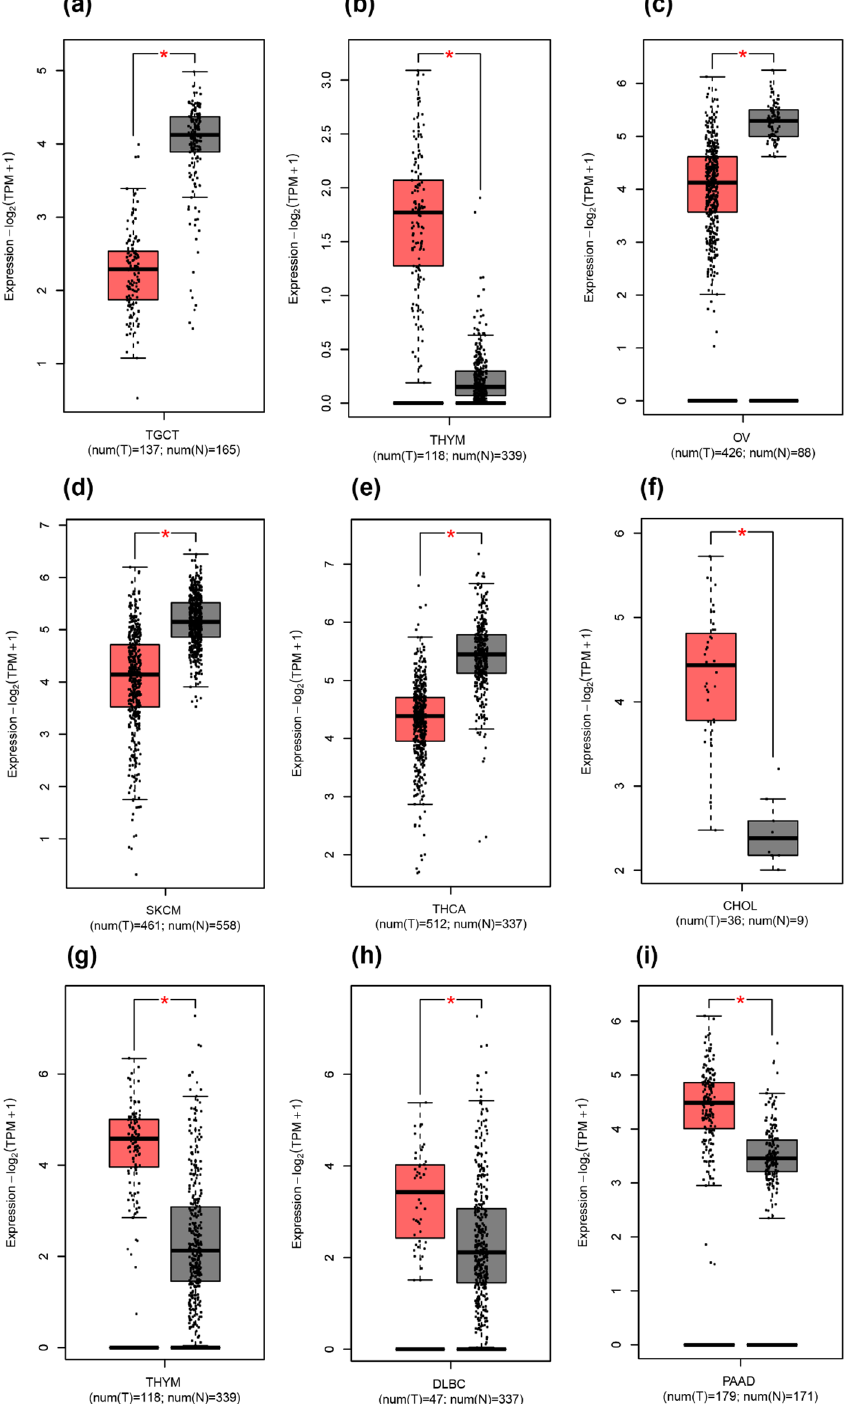
Figure 6. Box plot representation of the comparative expression levels of THAP9 ( a , b ) and THAP9- AS1 ( c – i ) in different tumor samples (red) vs. normal tissue samples (grey) from TCGA and GTEx generated using GEPIA2. Note: * p < 0.01. GEPIA2 uses one-way ANOVA, taking the pathological stage (X-axis) as the variable for performing differential expression of the input gene. The expression data used for the analysis was log2(TPM+1) (y-axis)-transformed. ( a ) THAP9 is downregulated in TGCT and ( b ) upregulated in THYM. ( c – e ) THAP9-AS1 is downregulated in OV, SKCM, and THCA and ( f – i ) upregulated in CHOL, THYM, DLBC, and PAAD (* p < 0.05).